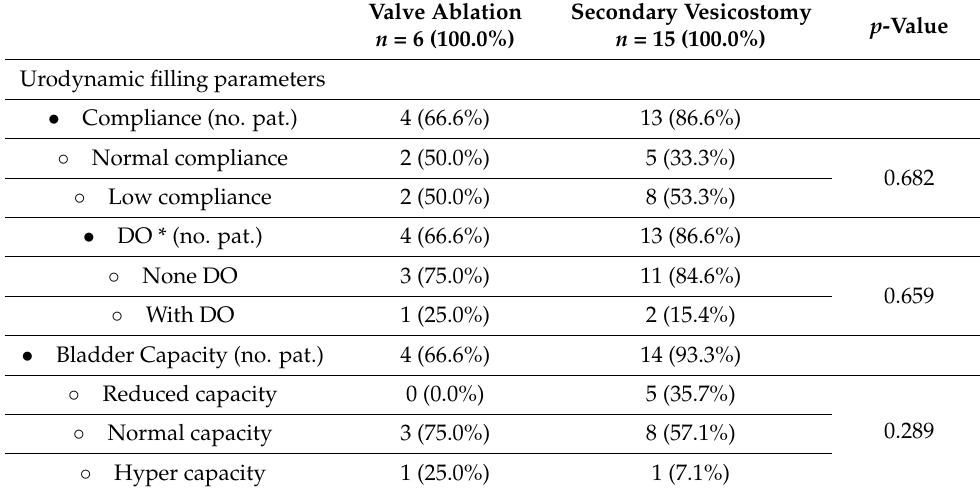
Table 3. Postoperative outcome of urodynamic measurement.